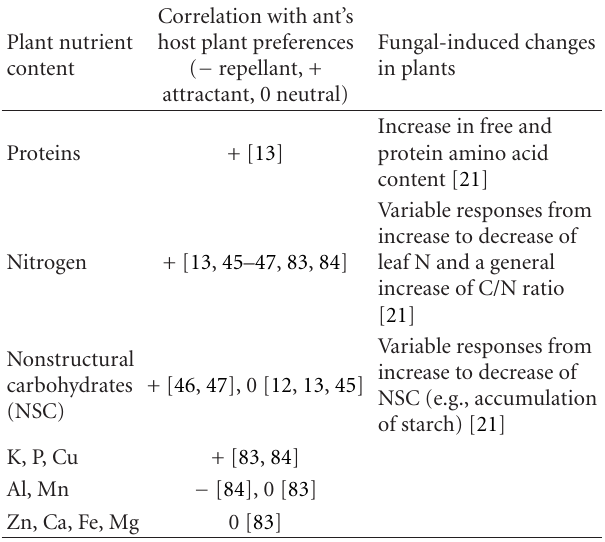
Table 2: A review of studies that correlate plant nutrients with ant foraging preferences, with additional observations of whether these key plant traits change as a result of plant-fungal interactions (pathogens).